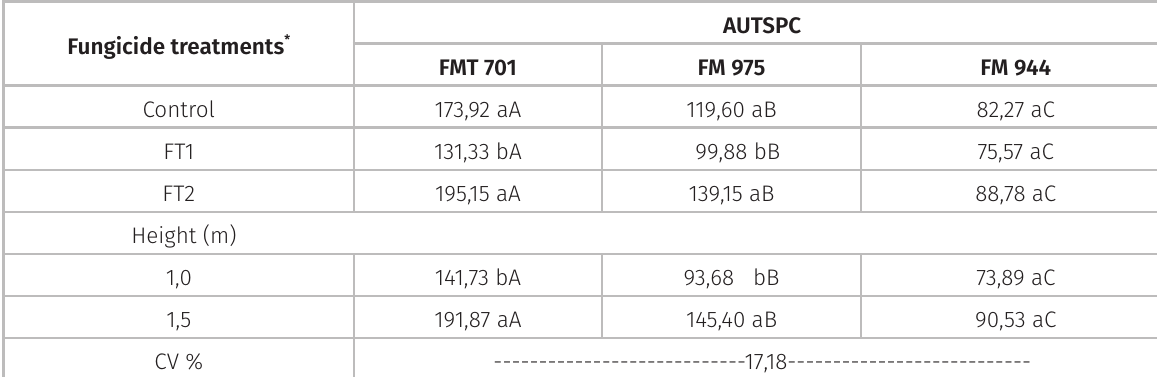
Table III. Area under the target spot progress curve (AUTSPC) of three cotton cultivars submitted to fungicide treatments (FT) and two plant heights. Chapadão do Sul, MS. Crop season: 2014/15. Fungicide treatments *